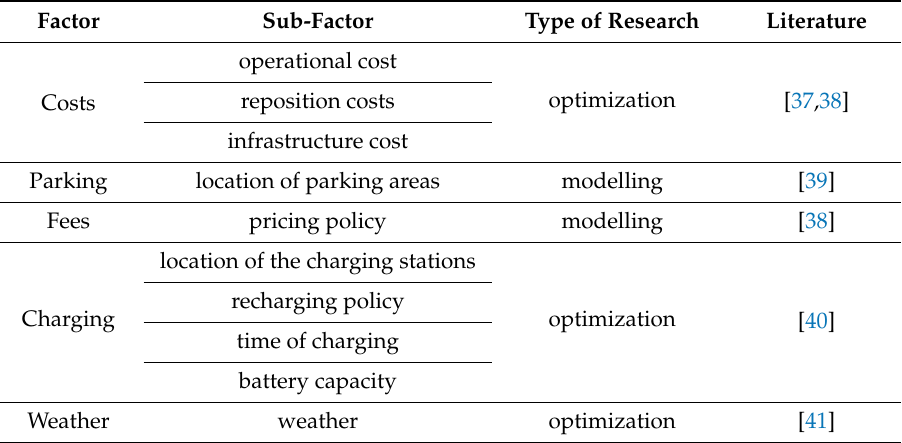
Table 3. Factors that are taken into account when modeling and optimizing electric scooter-sharing and electric moped-sharing systems—a literature